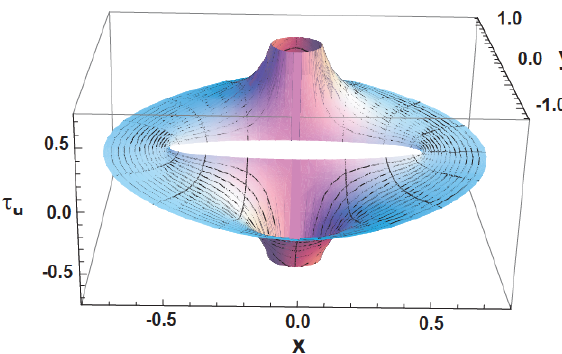
On the elliptical hole u = u 0 , one determines from (41) that the boundary condition on traction is satisfied as τ u is everywhere zero except at the locations of the concen- trated loads, which are singularities. This behavior is de- picted in Figure 3.